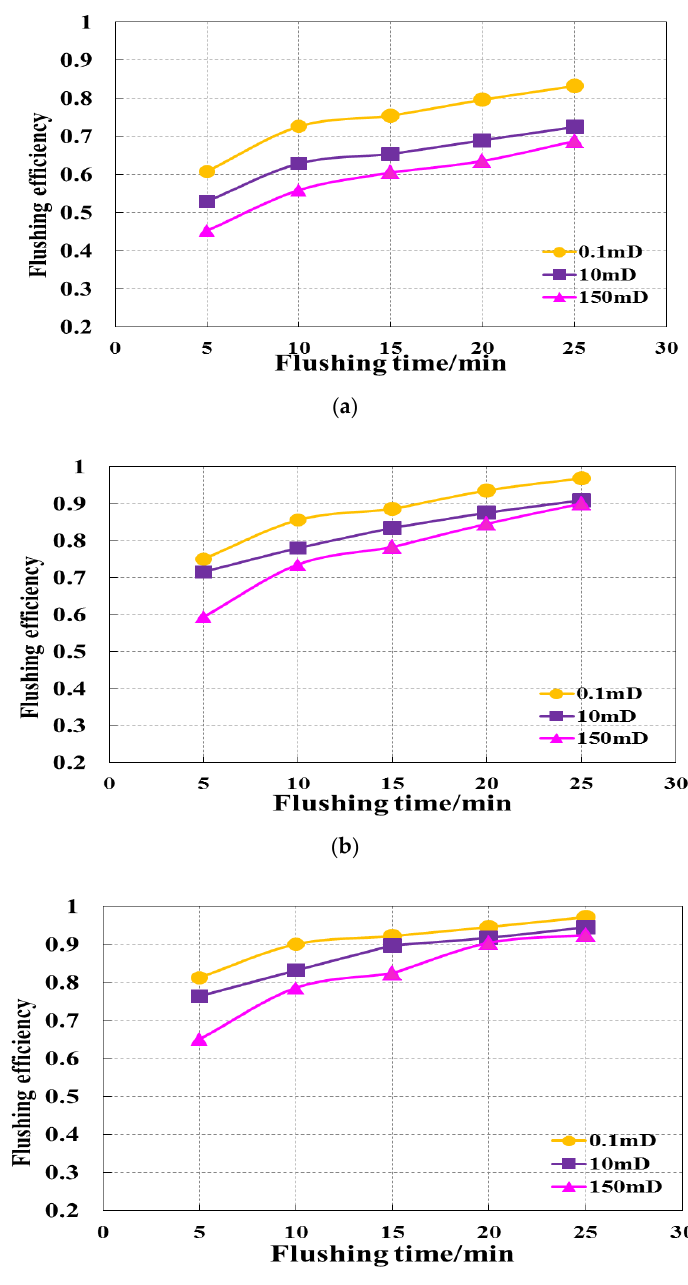
Figure 10. Variation of flushing time and flushing efficiency of different cores under the condition of 20% flushing concentration. ( a ) is flushing displacement 10 L / min, ( b ) is flushing displacement 25 L / min, ( c ) is flushing displacement 35 L / min. (3) The concentration of flushing solution is 30%